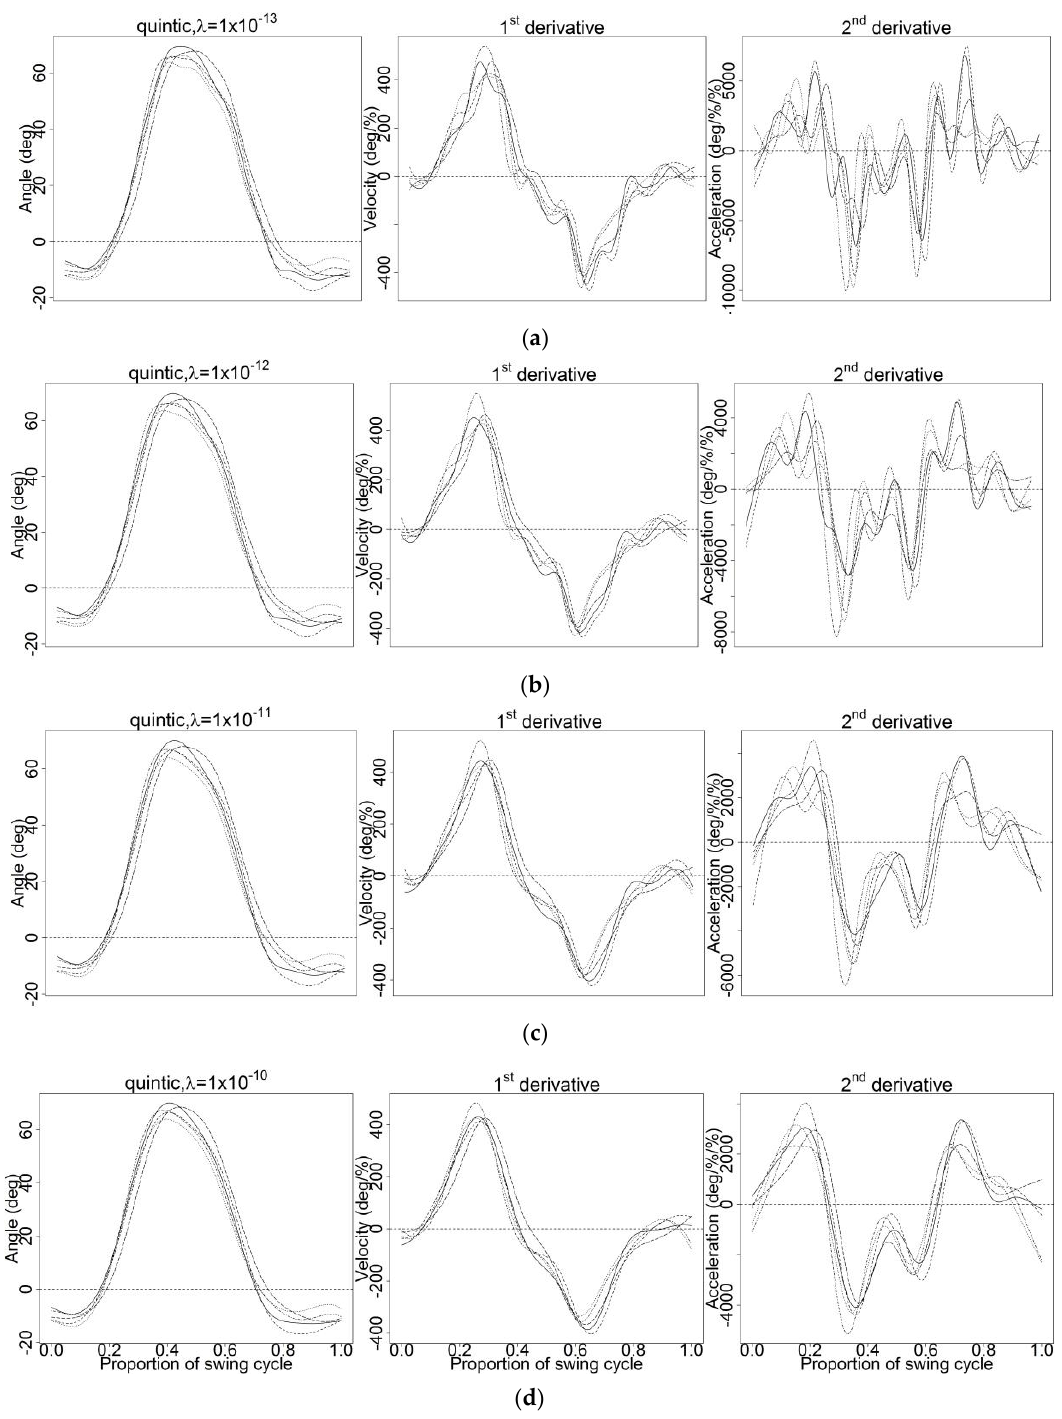
Figure A4. Smoothing using quintic spline basis with various values of λ : ( a ) 1 × 10 − 13 , ( b ) 1 × 10 − 12 , ( c ) 1 × 10 − 11 , and ( d ) 1 × 10 − 10